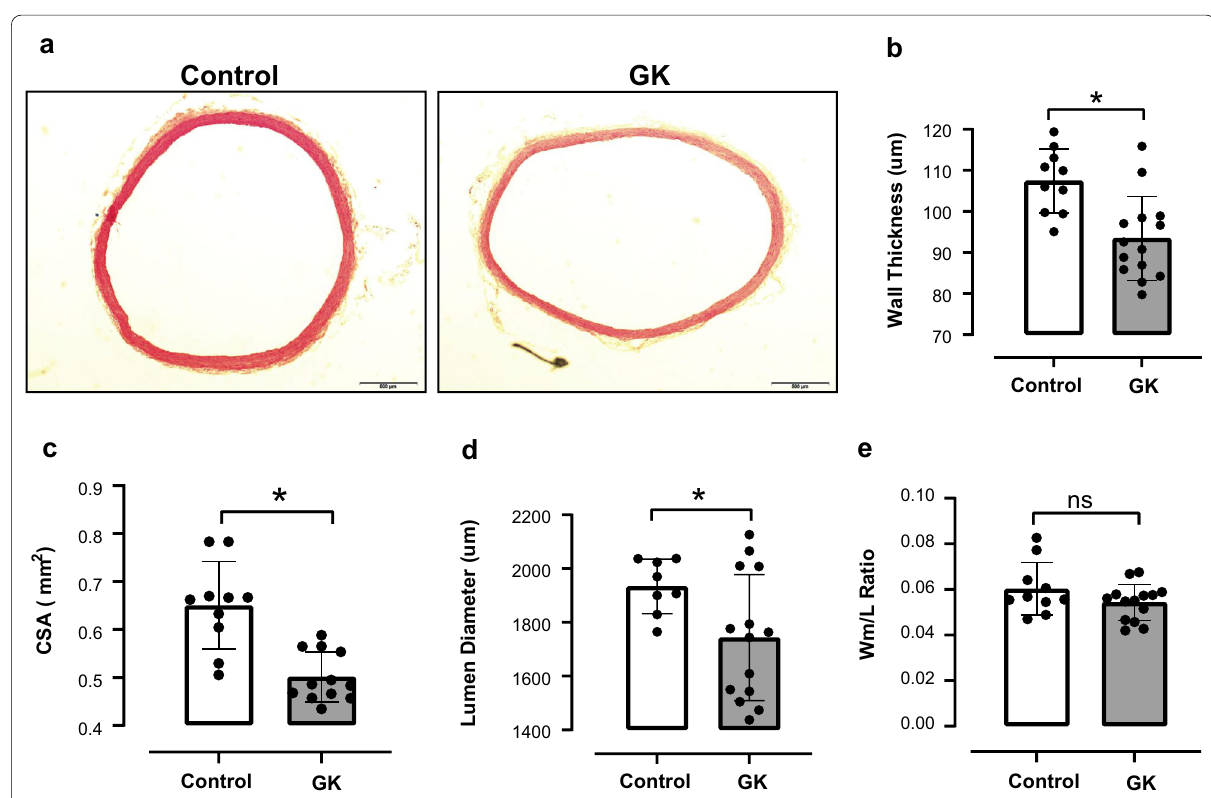
Fig. 3 Vascular remodeling in aortas from GK rats in advanced T2DM. a Representative photomicrographs of the aortic cross‑sections from the control and GK groups stained with H&E. Scale bar: 500 μm. b Wall thickness (Wm) (μm), c Cross‑Sectional Area (CSA) (mm 2 ), d Lumen diameter (μm), and e Wall‑to‑lumen (W m /L) ratio were obtained using Image J analysis software. *p < 0.05 vs. control, n means